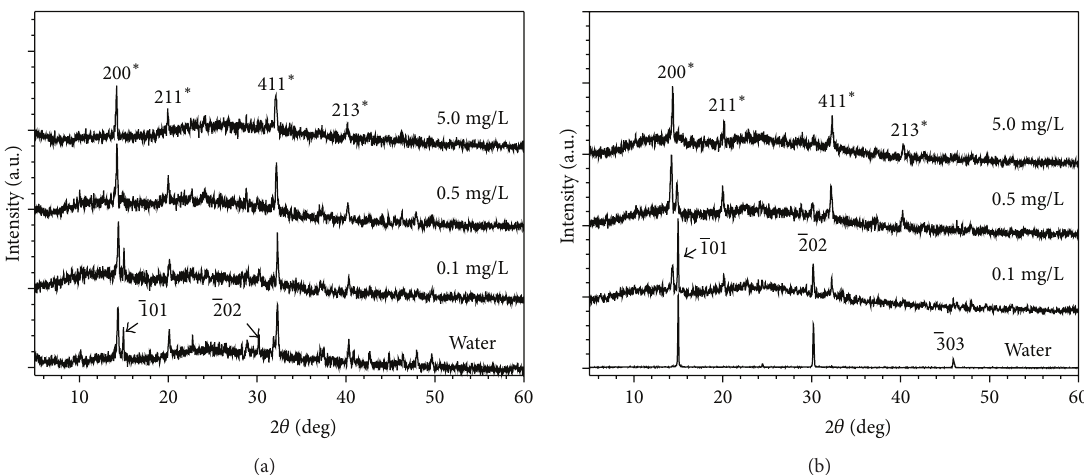
Figure 3: XRD patterns showing the effects of C 6 S concentration on conformation percentage of submicron COD into COM in the presence of different C 6 S concentrations and different acting times ( 𝑡 ). (a) 𝑡 = 48 h; (b) 𝑡 = 72 h.